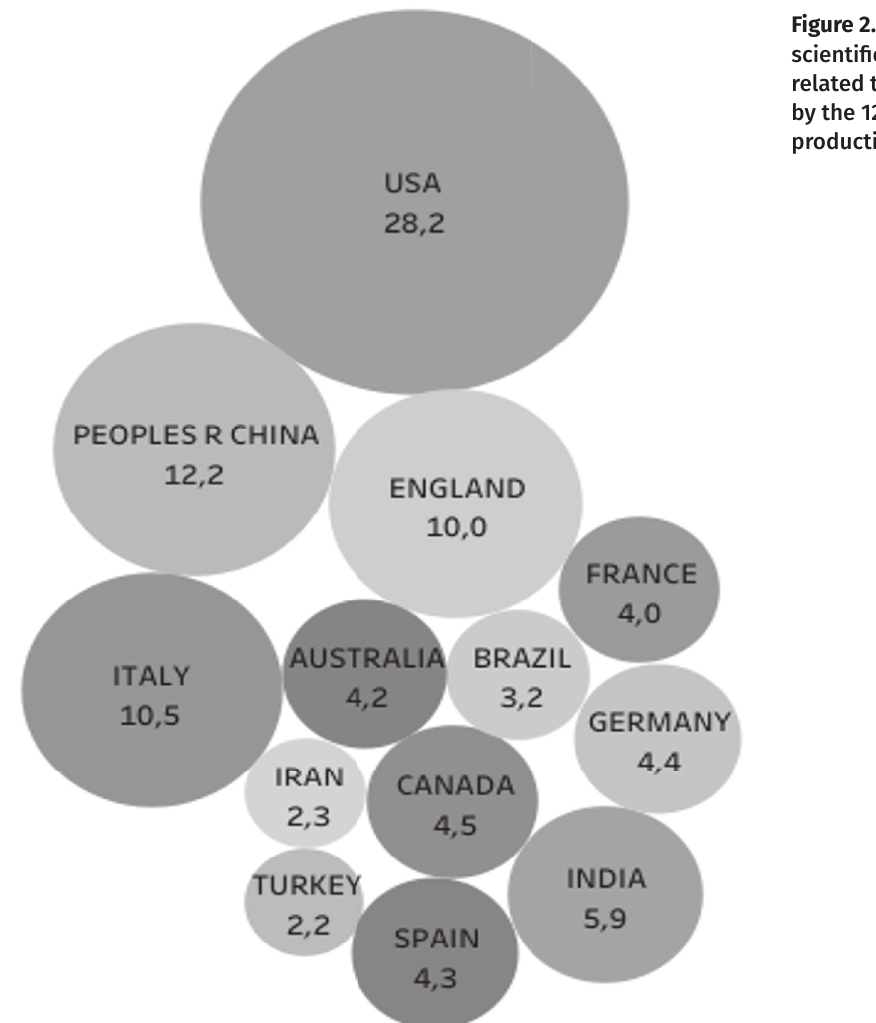
Figure 2. Output